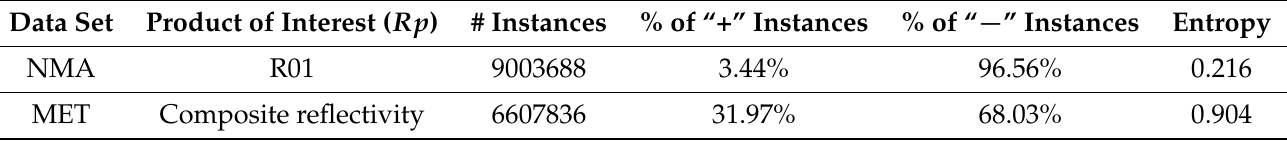
Table 1. Description of the data sets.